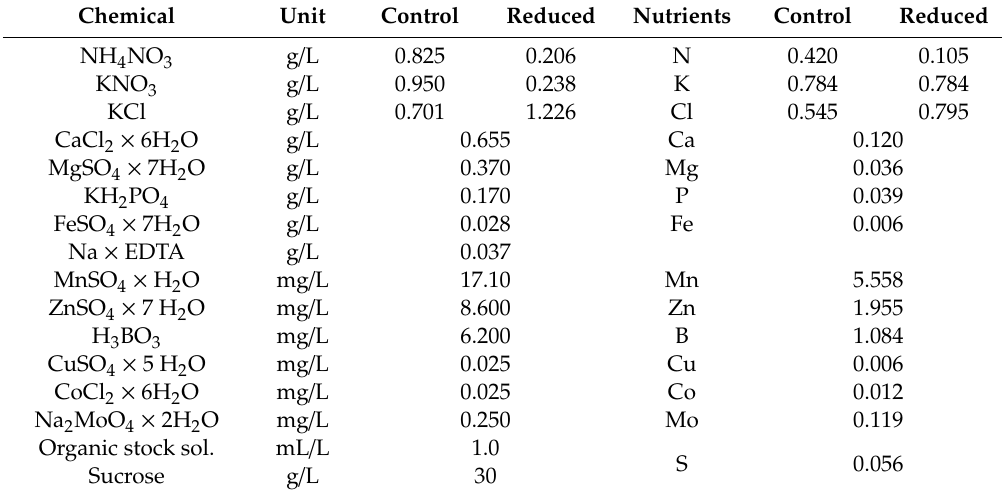
Table 7. Composition of the nutrient solution used in the control and reduced N treatment of the N e ffi ciency